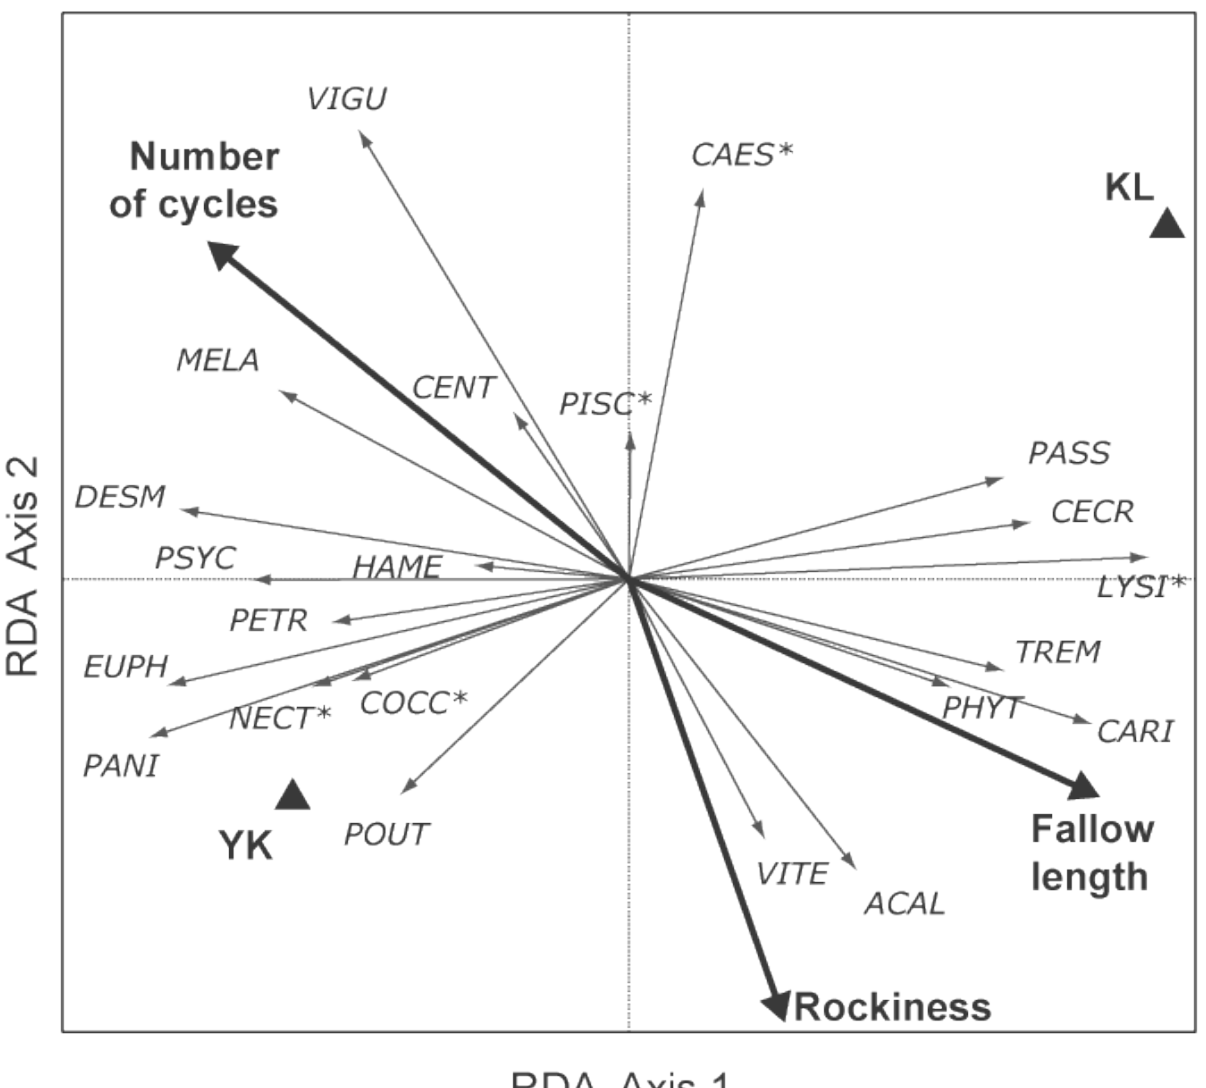
Fig. 6. Correlation biplot from the redundancy analysis (RDA) of the relative frequency of 17 forage and 5 firewood species constrained by forest type, fallow history, and rockiness. In this biplot, correlations between species and the quantitative explanatory variables fallow length, number of cycles, and rockiness are represented by the angle between their vectors, such that the smaller the angle, the stronger the association. The relationship of forest type, YK or KL, with species or with other quantitative variables can be inferred by projecting its centroid on the vector at a right angle; projections at more extreme ends of the vector indicate a stronger relationship between the variables. Finally, the length of a species’ vector indicates the amount of its variation explained by the first two axes of the ordination. Species' codes as in Tables 1 and 2. The five species used for firewood are indicated by an